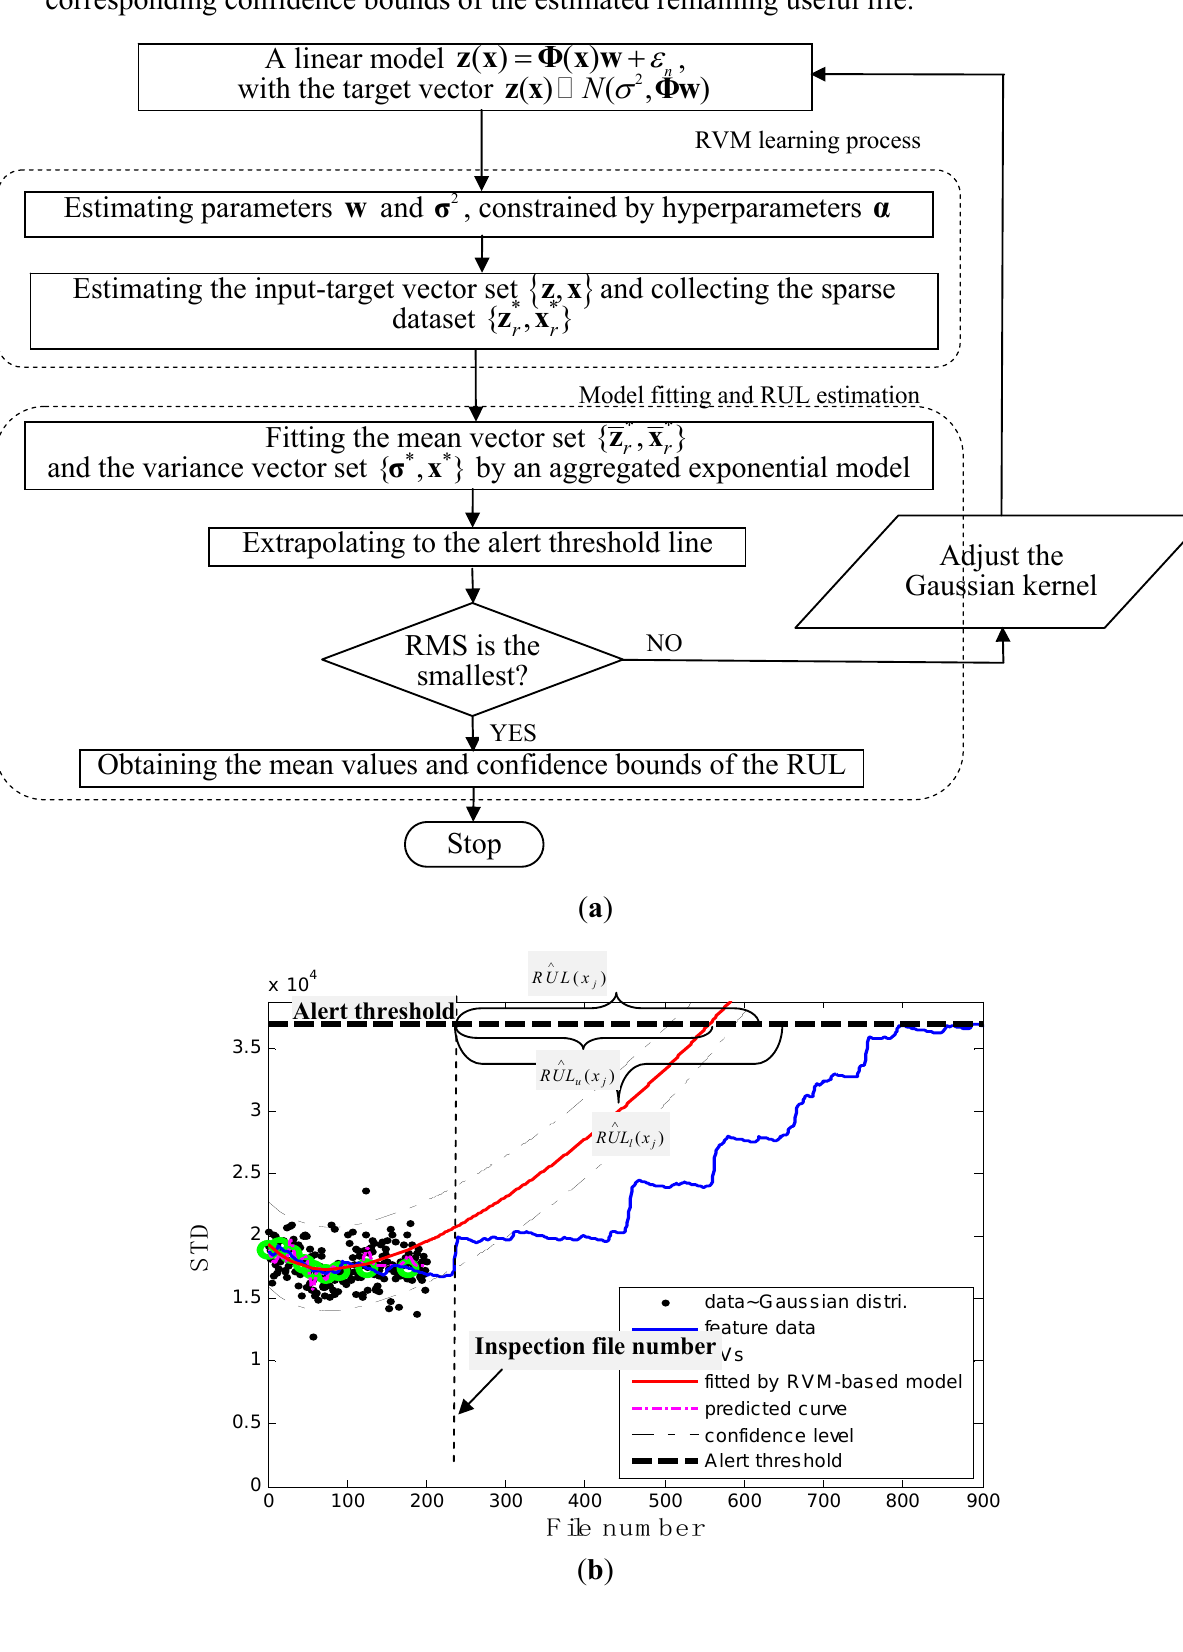
Figure 7. RUL estimation process ( a ) Flowchart ( b ) The mean values and the corresponding confidence bounds of the estimated remaining useful